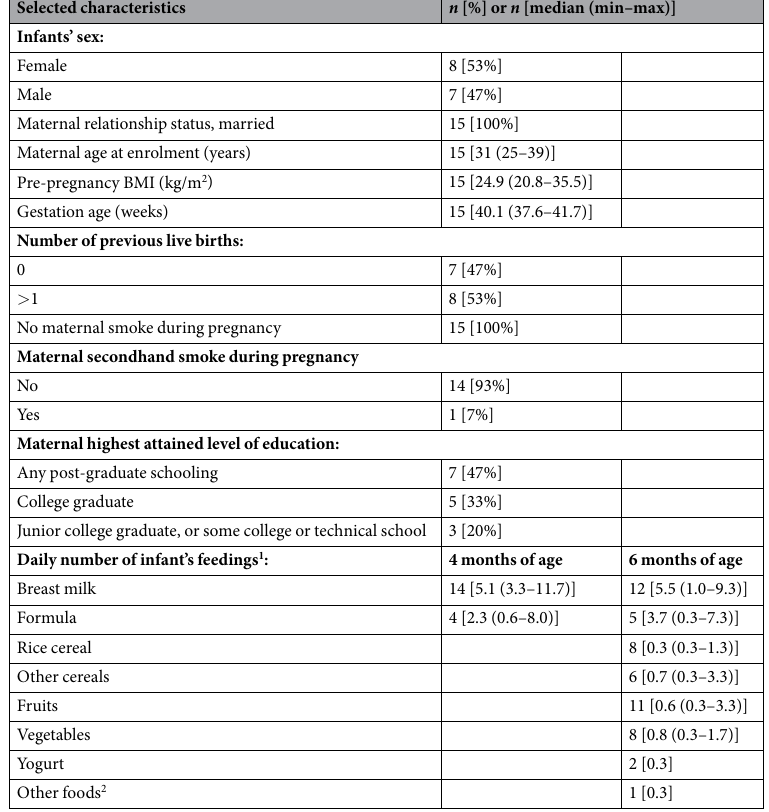
Table 1. Selected characteristics of the study population. 1 Average daily feedings based on a 3 day food diary. 2 Refers to a participant that reported a meal of turkey with rice without specifying the amount consumed of each product